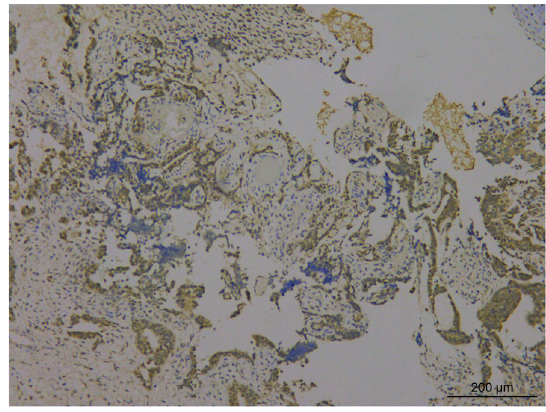
Fig. 7 Immunohistochemical staining visualized at 100 magnification. The expression of AFP was positive in the yolk × sac tumor component of the